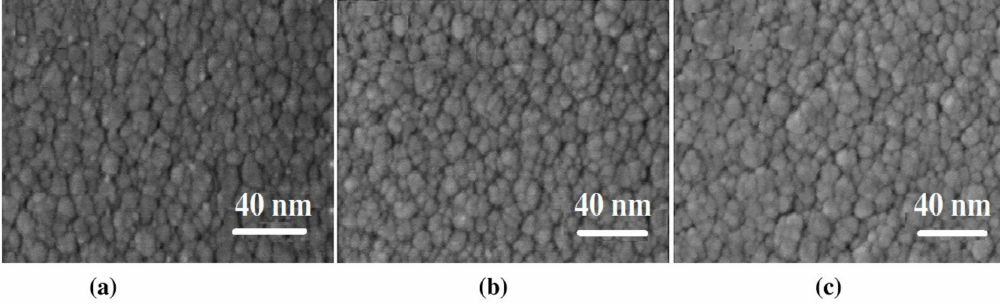
Figure 7. SEM images of by: ( a ) as-deposited, thermal shock test in air for ( b ) 203.2 h, ( c ) 812.8